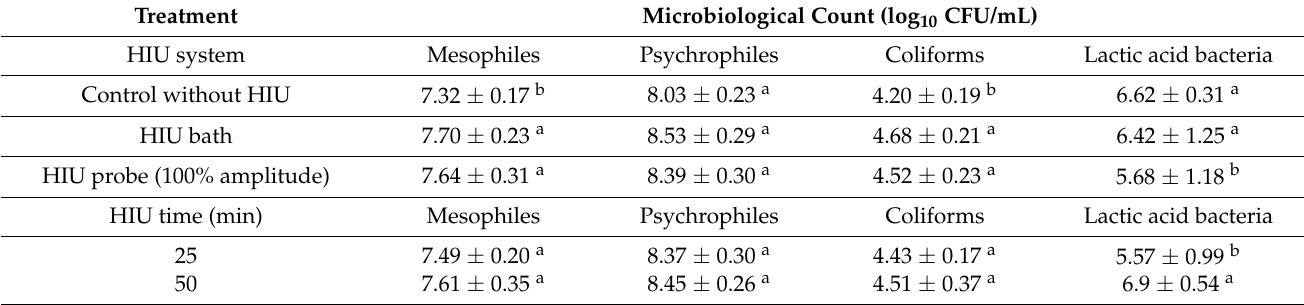
Table 4. Effect of HIU system and HIU time on the count of mesophiles, psychrophiles, lactic acid bacteria, and coliforms of bovine Longissimus lumborum stored for 7 days at 4 ◦ C. Microbiological Count (log 10